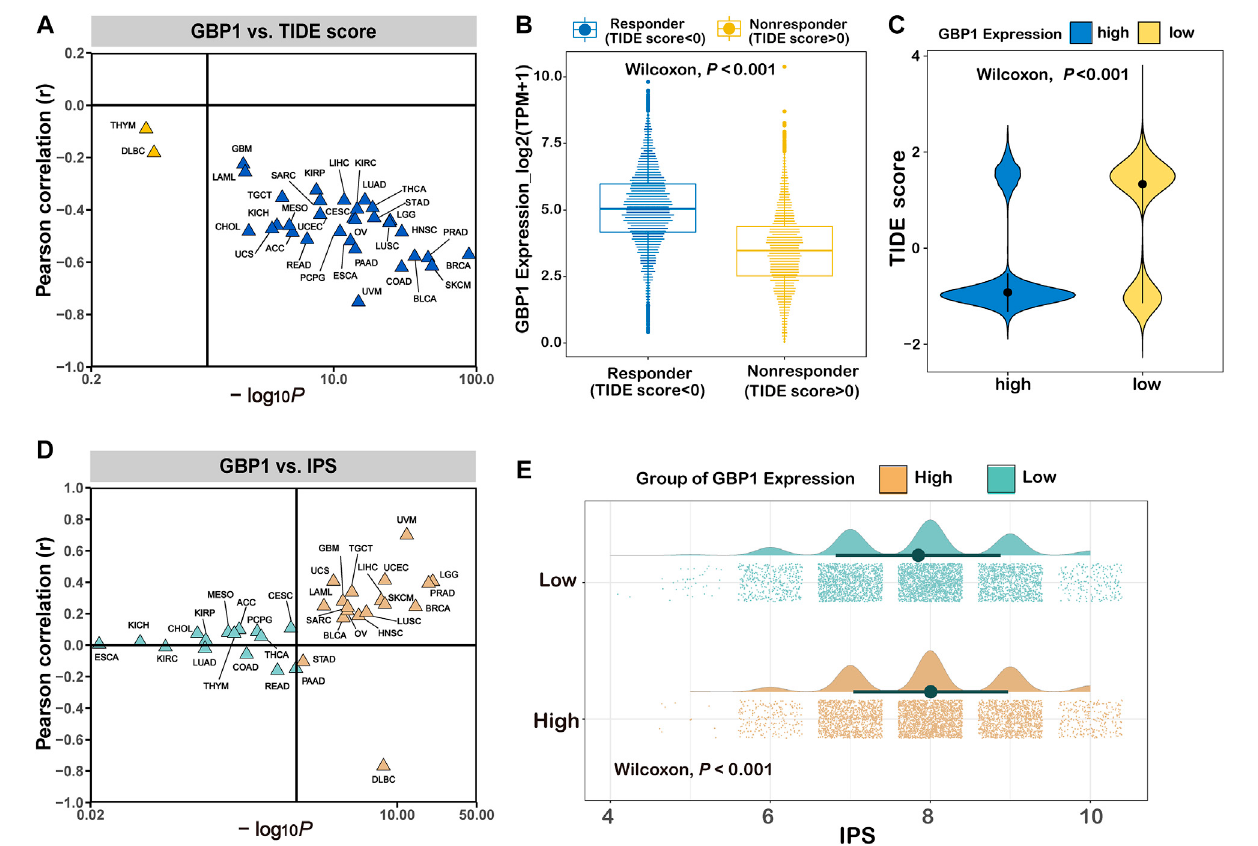
FIGURE 7 | Prediction of immunotherapy response in patients with different expression levels of GBP1. (A) The correlation between GBP1 expression and TIDE scores across 33 cancer types. (B) The expression level of GBP1 in responders and non-responders. (C) The distribution of TIDE score in the high and low GBP1 expression groups. (D) The correlation between GBP1 expression and IPS across 33 cancer types. (E) The distribution of IPS in the high and low GBP1 expression groups. TIDE, immune dysfunction and exclusion; IPS,